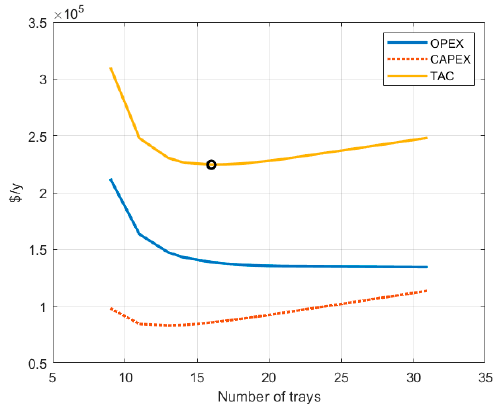
Figure 6. Distillation TAC under nominal operating conditions.